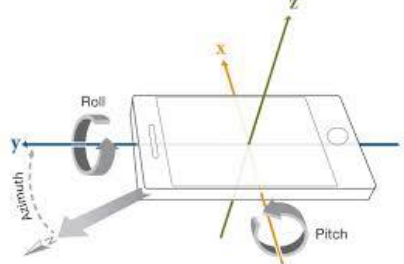
Figure 4. Azimuth, pitch, and roll in smartphones (matchwork.com, seen 2014)